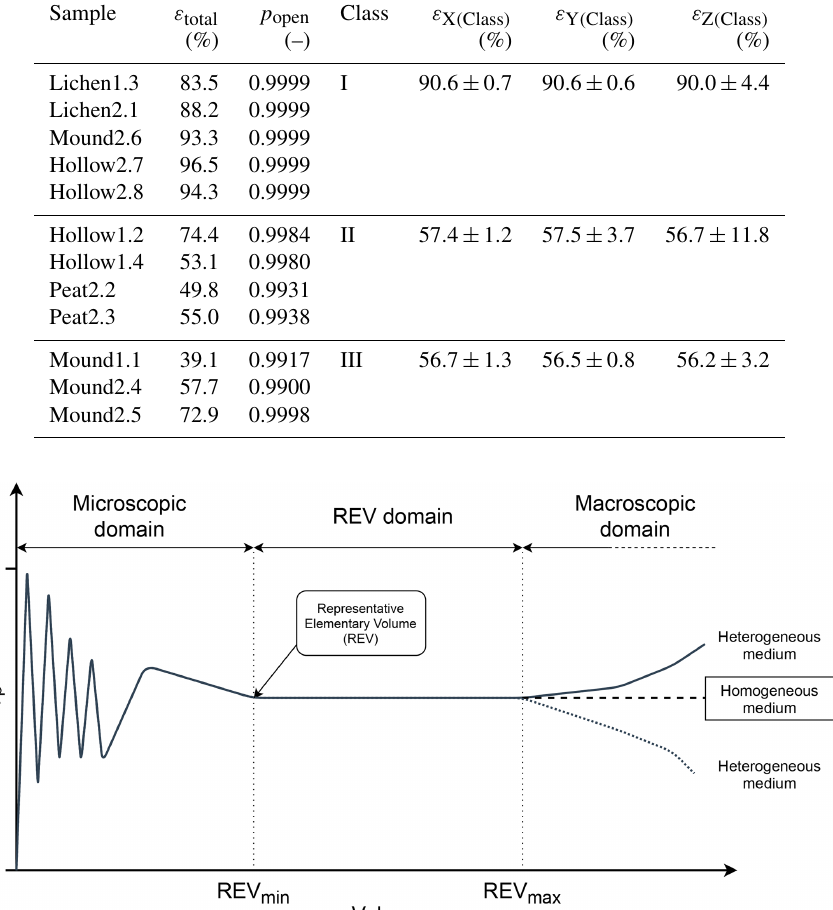
Figure 2. Schematic representation of fluctuations of a generic property ϕ β in conjunction with volume (adapted following Brown and Hsieh,